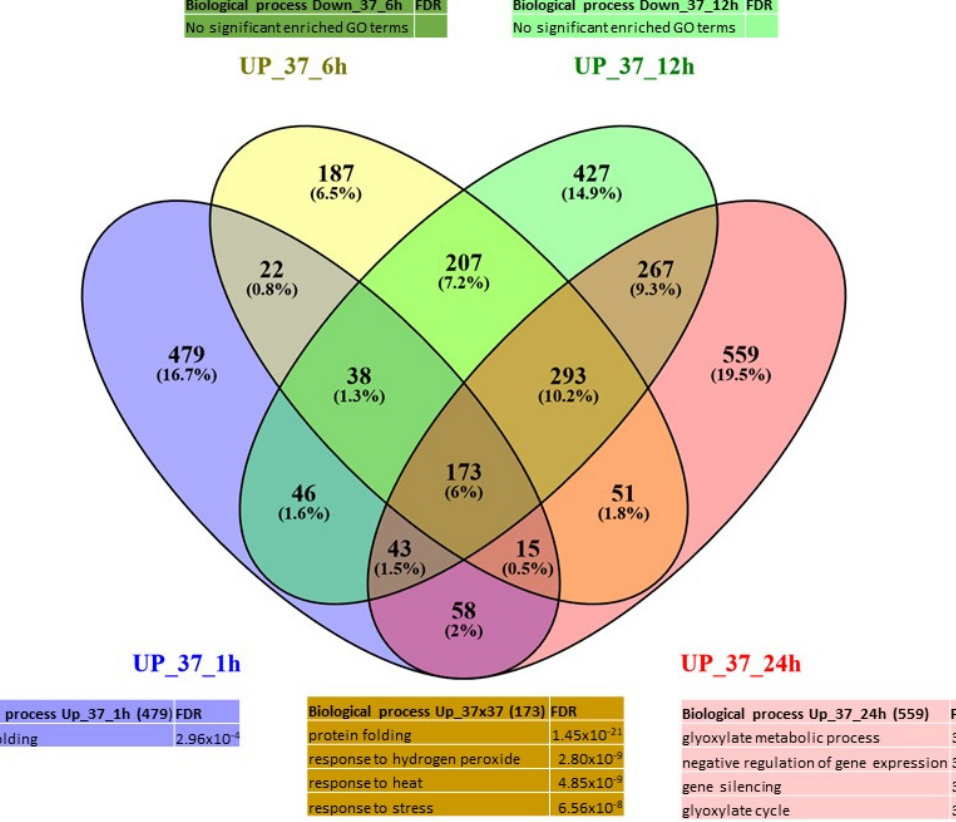
Figure 5. Venn diagram of expression data analysis at 37 °C of the up-regulated genes at 1, 6, 12 and 24 h and associated GO terms. UP_37_1h = up-regulated DEG at 37 °C at 1 h, UP_37_6h = up-regulated DEG at 37 °C at 6 h, UP_37_12h = up-regulated DEG at 37 °C at 12 h, UP_37_24h = up-regulated DEG at 37 °C at 24 h.